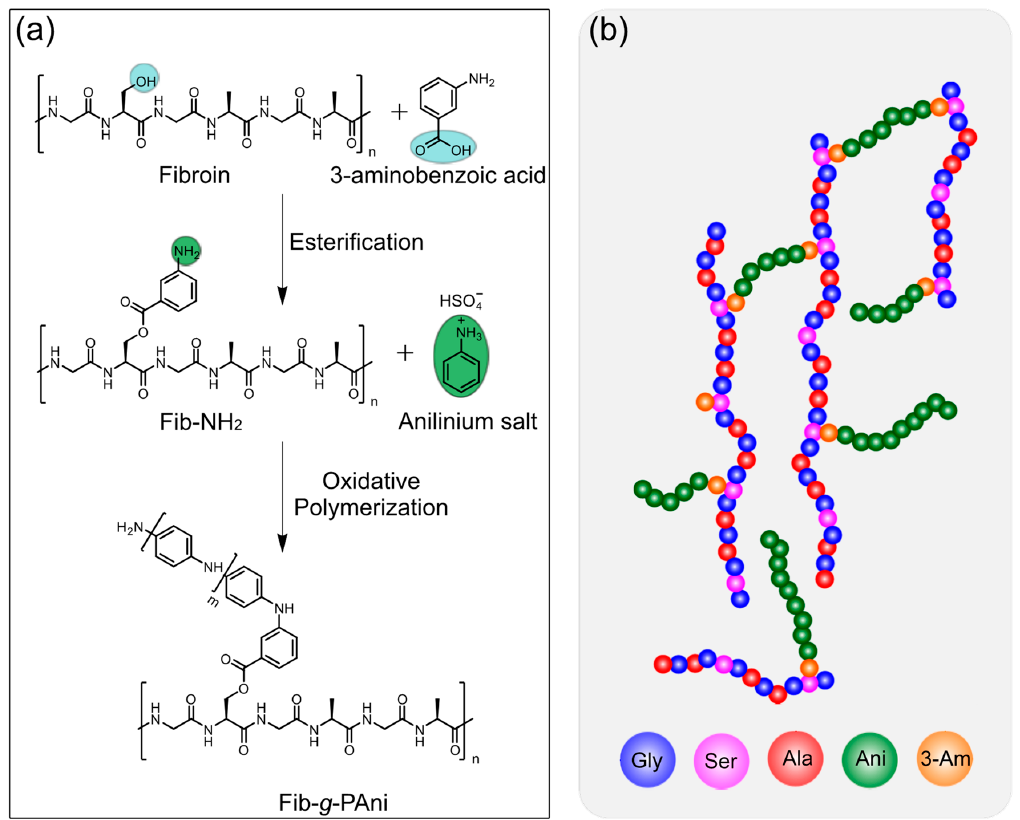
Figure 1. ( a ) Consecutive reactions for copolymer synthesis fibroin-g-polyaniline (Fib- g -PAni), and ( b ) proposed model of Fib-g-PAni. ( b ) proposed model of Fib- g